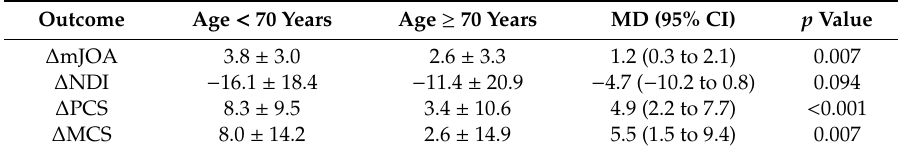
Table 3. Delta values (change in the scores from baseline) at two years for younger and older cohorts for all outcomes.